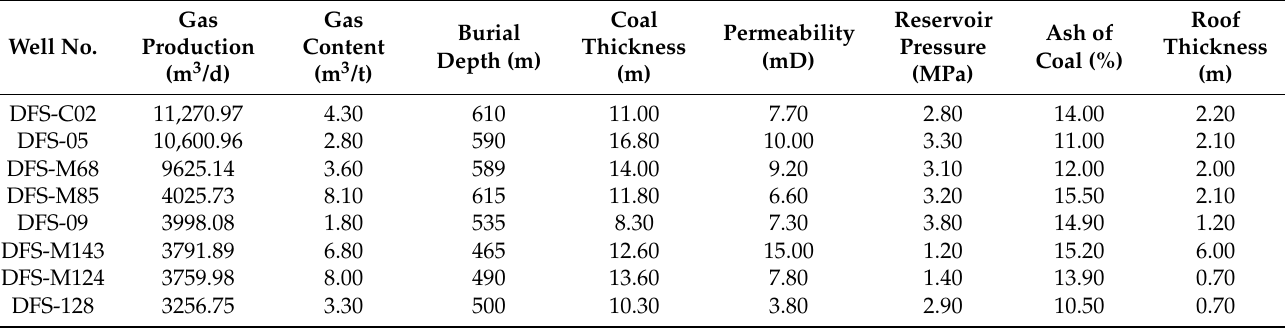
Table 2. Geological information of CBM